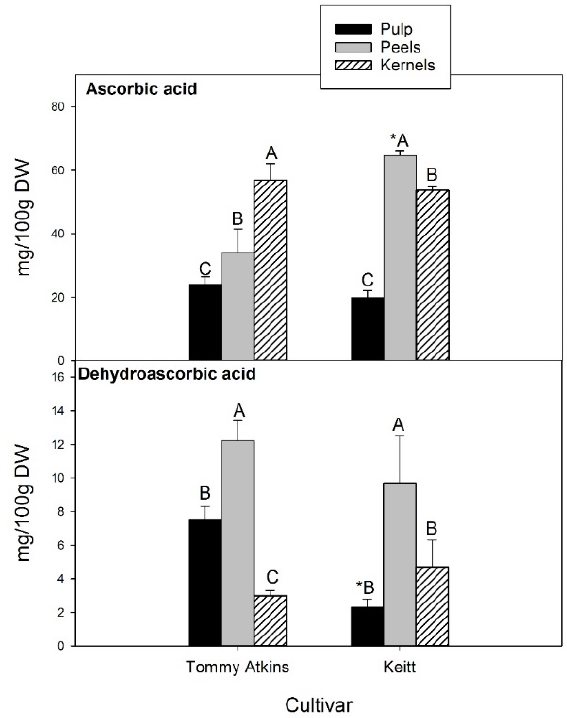
Figure 4. Ascorbic and dehydroascorbic acid content in three fractions (pulp, peel and kernel) of mango fruit. Data, expressed as mg/100 g dw, are the mean ± standard deviation of five independent replicates ( n = 5). Data were submitted to one-way analysis of variance (ANOVA), differences among groups were detected using multiple comparison procedures (Tukey test). Significant differences between cultivars within each fruit fraction were highlighted by an asterisk (*); different capital letters indicate differences among fruit fractions for the same cultivar ( p <